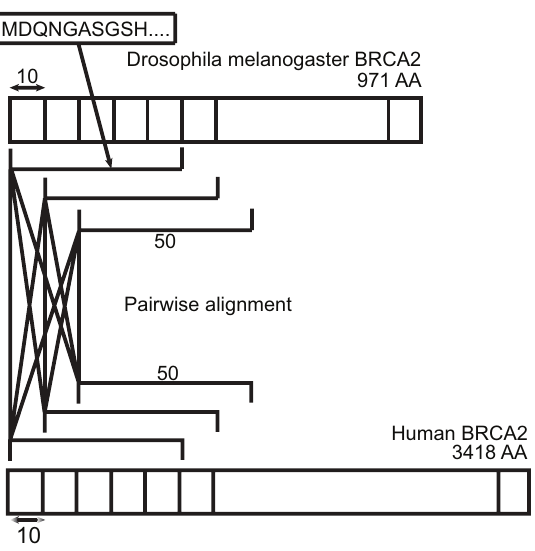
Figure S1. FRAGAL methodology. The BRCA2 protein sequences from Drosophila melanogaster and humans are split into fragments of parameterized length (50 in this case), at a parameterized interval (10 in this case). All pairs of fragments are aligned, and the results stitched such that there are no overlap in any given match and the order of the match is not interspersed. The alignment is done using the global alignment program ‘needle’ from the EMBOSS suite, and the gap penalties are set to 25 to discourage gaps in the middle of the alignment.